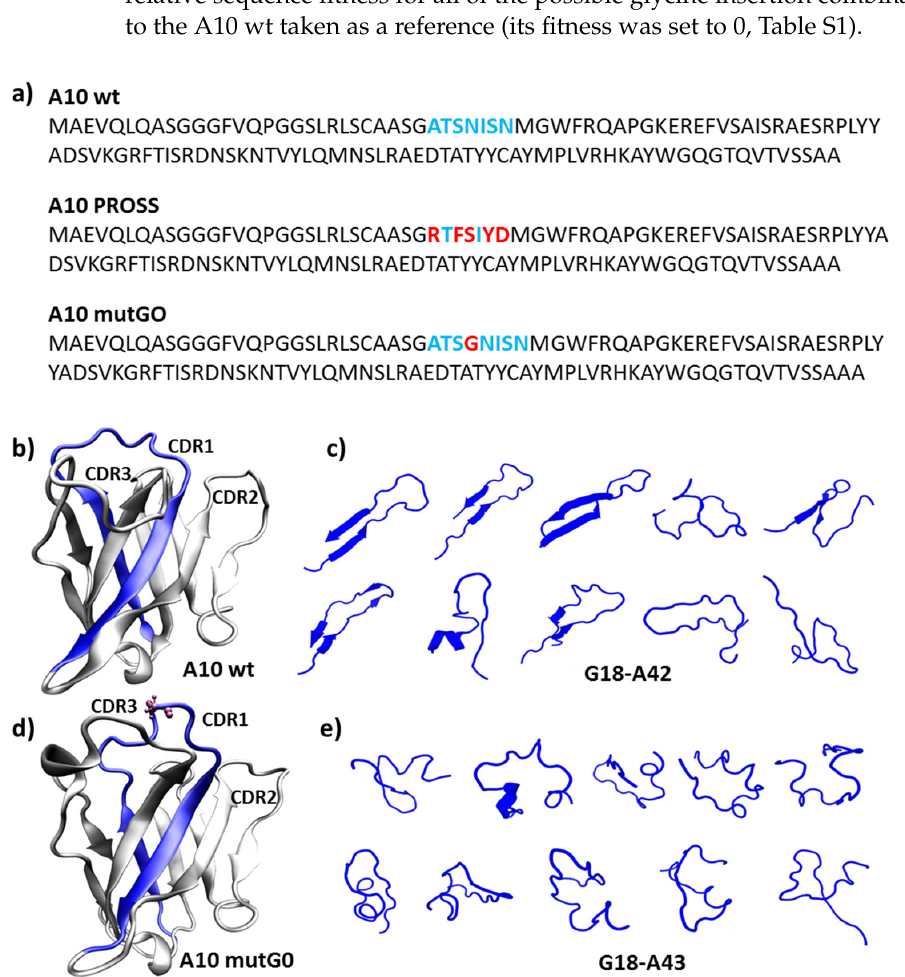
Figure 1. Nanobody sequences and structural effects induced by the insertion of a glycine in A10 wt CDR1. ( a ) Sequences corresponding to A10 wt (CDR1 residues highlighted in blue), to A10 with mutations proposed by PROSS in CDR1 (red), and to the mutant A10 mutG0 (inserted glycine in red); ( b , c ) A10 wt and A10 mutG0 initial models ( d , e ) and putative three dimensional arrangements of nanobody-derived peptides as predicted by PEP-FOLD3. The initial models have been built by homology. In ( b – e ), the peptides (G18-A42 in A10 wt and G18-A43 in A10 mutG0) are highlighted in blue.